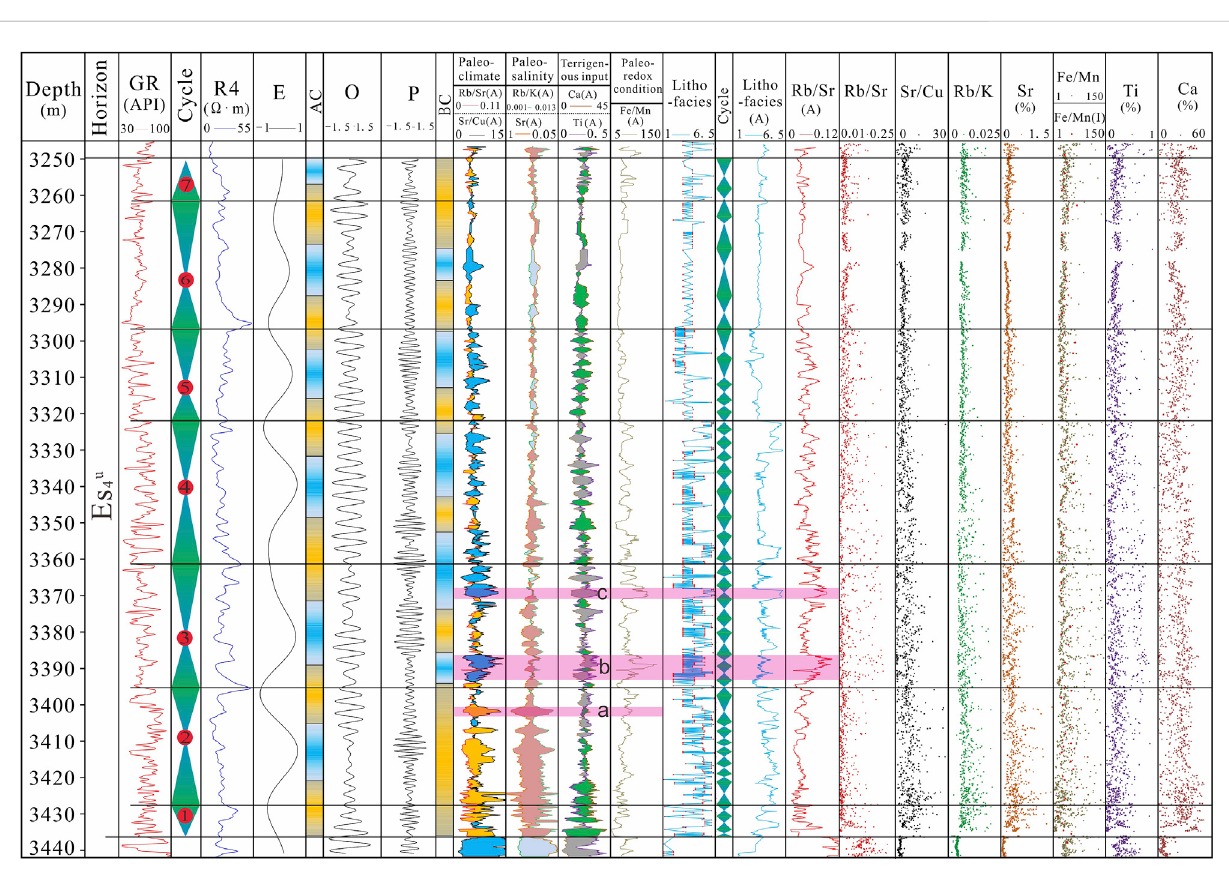
Frontiers in Earth